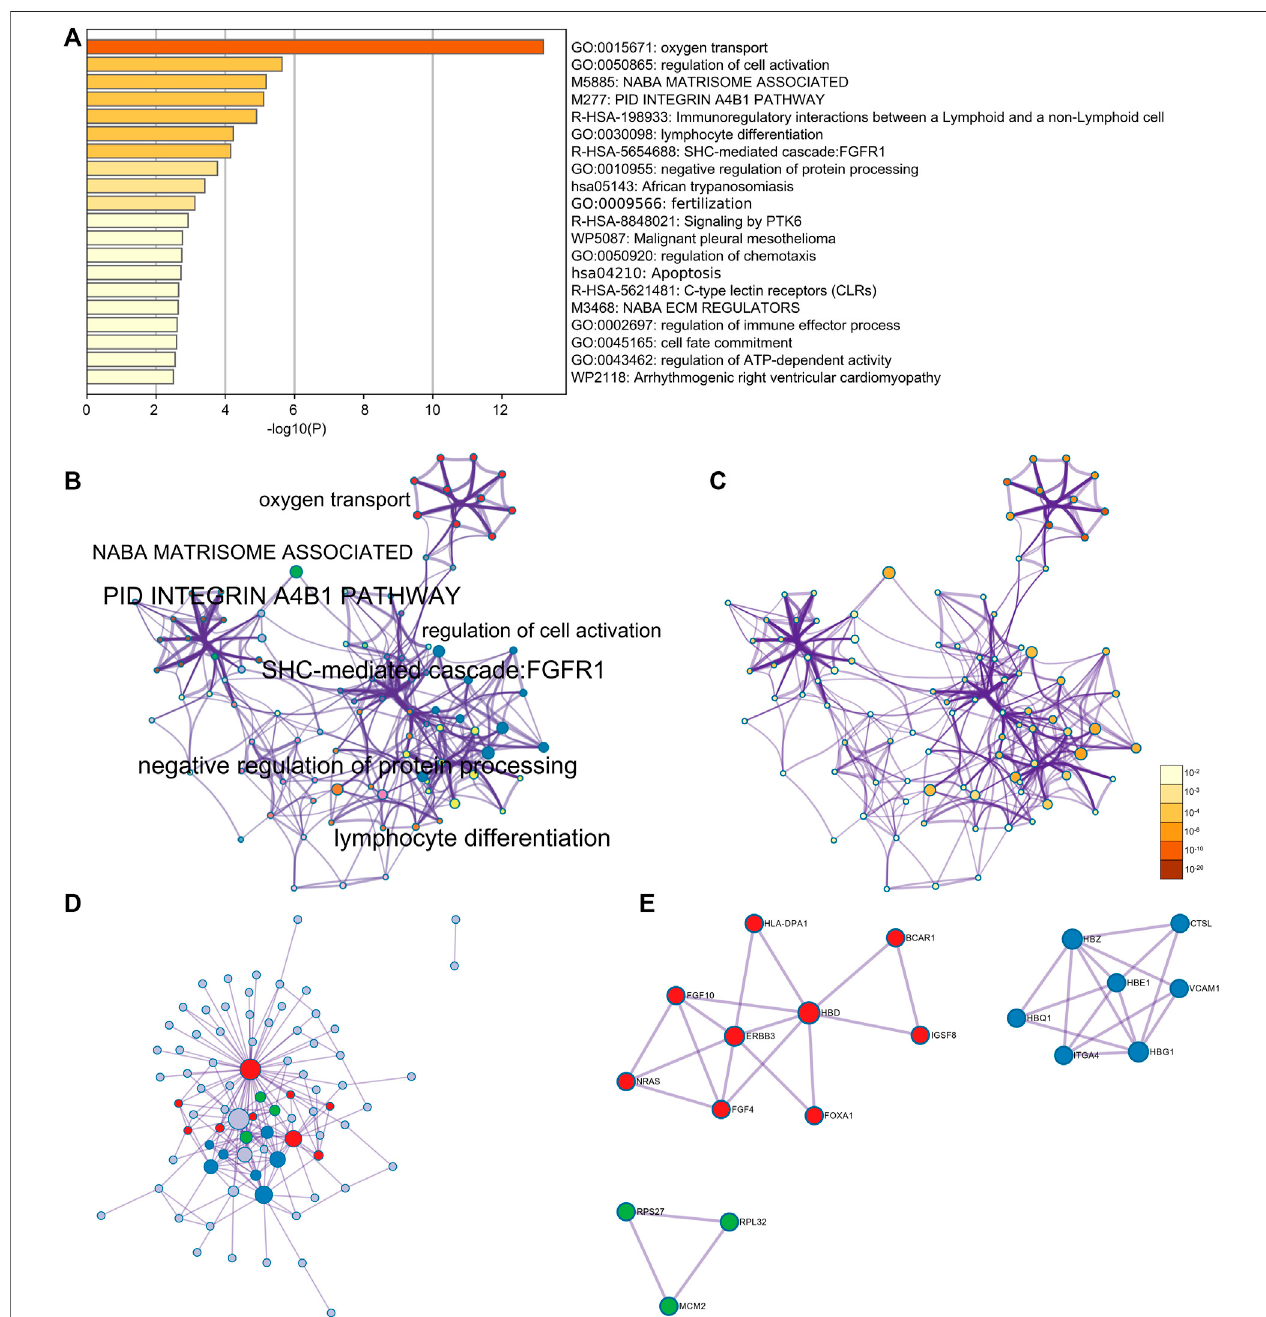
FIGURE 12 | Enrichment analysis for the relative genes of HBG1 and HBD via Metascape. (A) Relative genes of HBG1 and HBD were mainly enriched in oxygen transport, regulation of cell activation, apoptosis, and regulation of the ATP-dependent activity. (B) Network of enriched terms colored by cluster ID. (C) Network of enriched terms colored by the p -value. (D,E) Enrichment PPI network by the Metascape and MCODE components identi fi ed in the gene lists showed that HBG1 and HBD were at the core of the network.